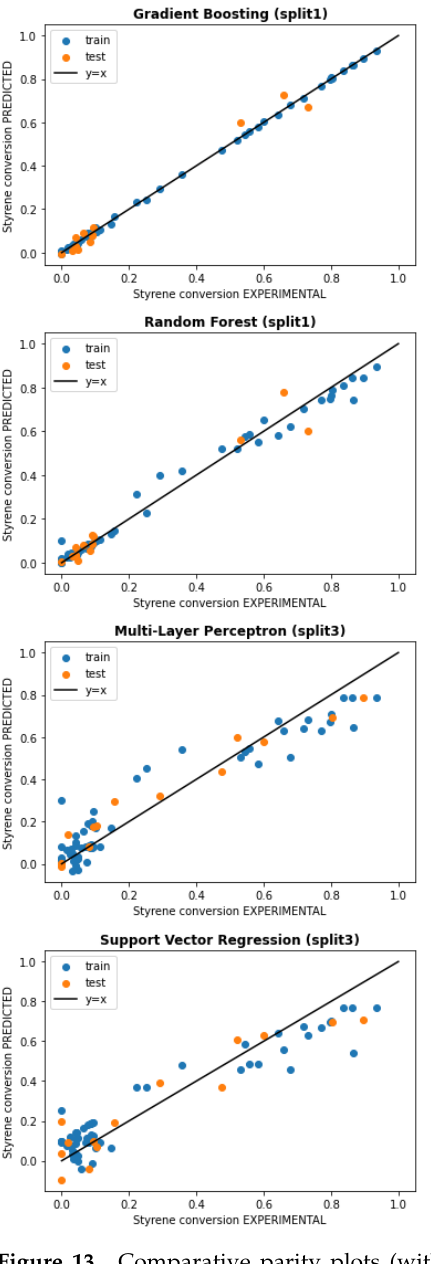
Figure 13. Comparative parity plots (with default HPs on left side, and with optimized HPs on right